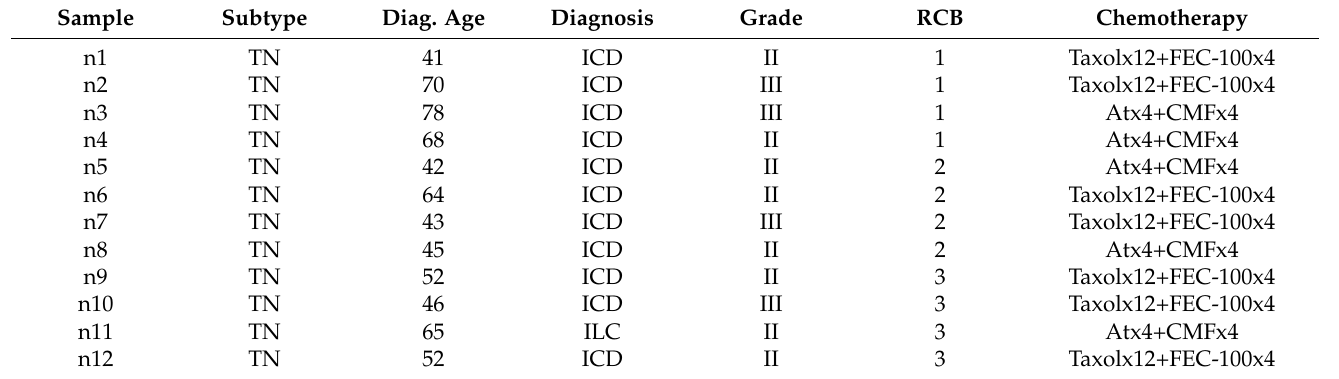
Table 1. Summary of clinical–pathological patient